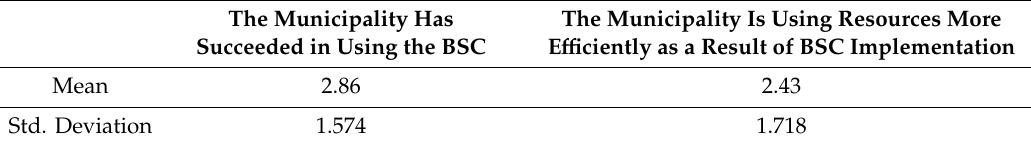
Table 29. Perceived success (N = 7) [Scale: